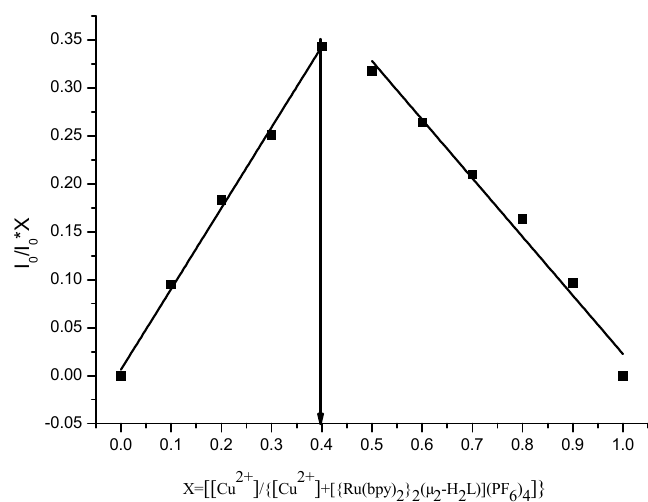
Figure 9. Job's plot in CH 3 CN/H 2 O ( v / v , 1:1) of the complex [{Ru(bpy) 2 } 2 ( μ 2 -H 2 L)](PF 6 ) 4 and Cu 2+ binding.